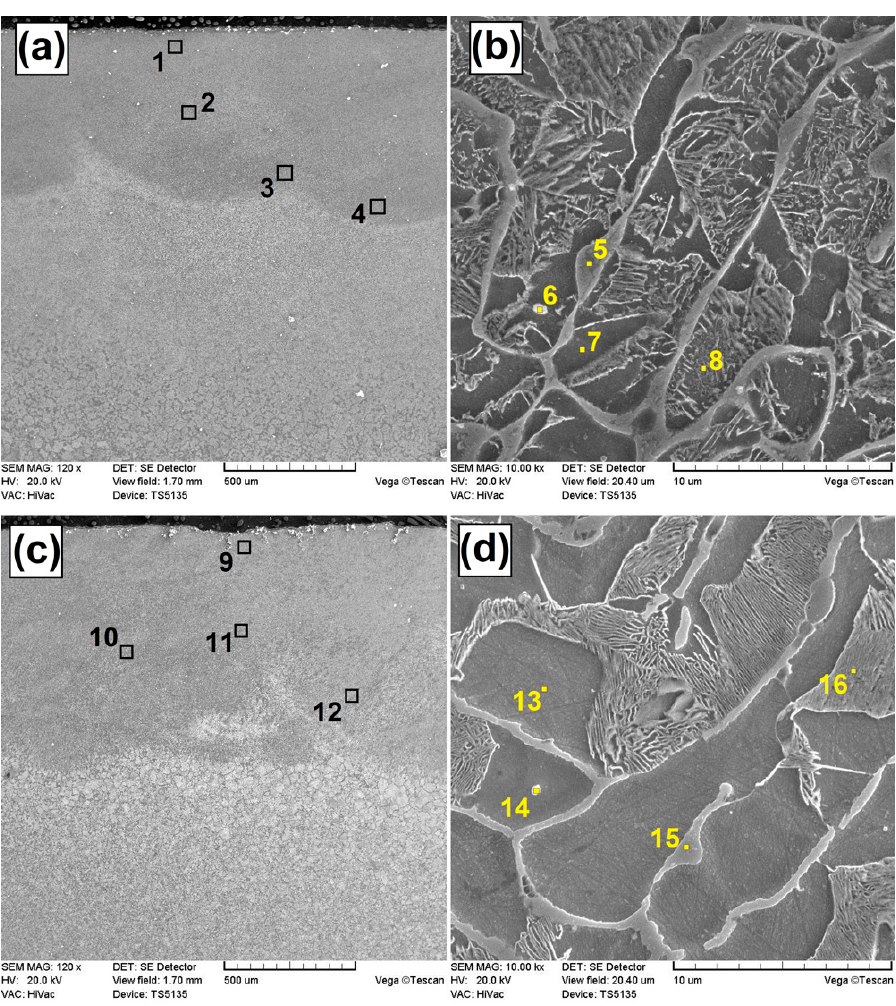
Figure 4. Microstructure of Fe–B coatings: ( a ) laser tracks of specimen #1; ( b ) remelted zone of specimen #1; ( c ) laser tracks of specimen #2; ( d ) remelted zone of specimen #2 (specimen numbers in accordance with Table 2).